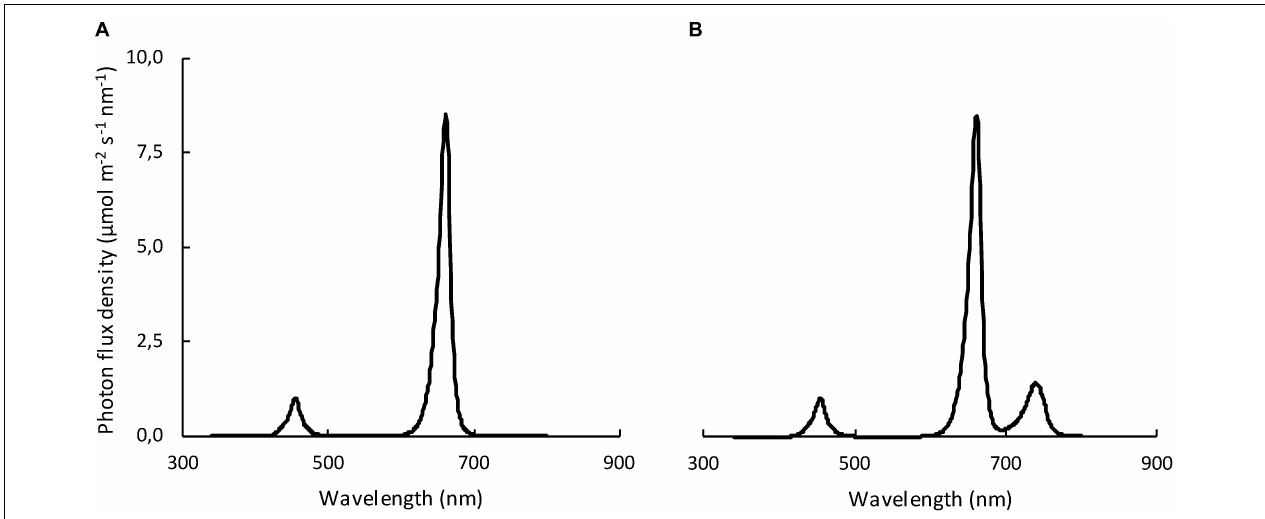
FIGURE 1 | Spectral distribution of the two light treatments: (A) without far-red (RB); (B) with far-red (RB + FR). Spectra were recorded and averaged on 21 locations along the cultivated area at pot level, measured by a spectroradiometer.